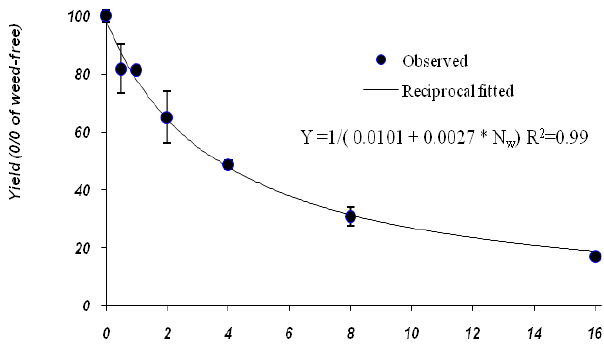
Fig. 1. Effects of weed density of ground cherry on sugar beet